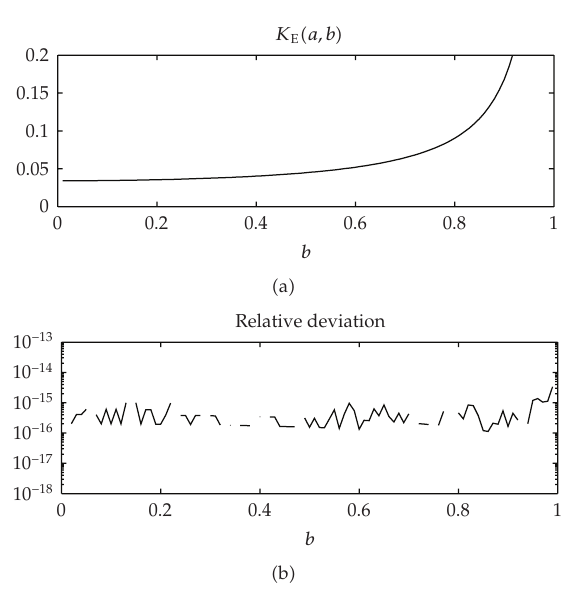
Figure 9: Comparison of the direct series evaluation (cid:2) solid (cid:3) and the analytic representation (cid:2) dashed (cid:3) for the even-order spectra K E with n (cid:6) 1, a (cid:6) π/ 6 as b is varied. The inset shows the relative di ff erence between the direct series evaluation and the analytic